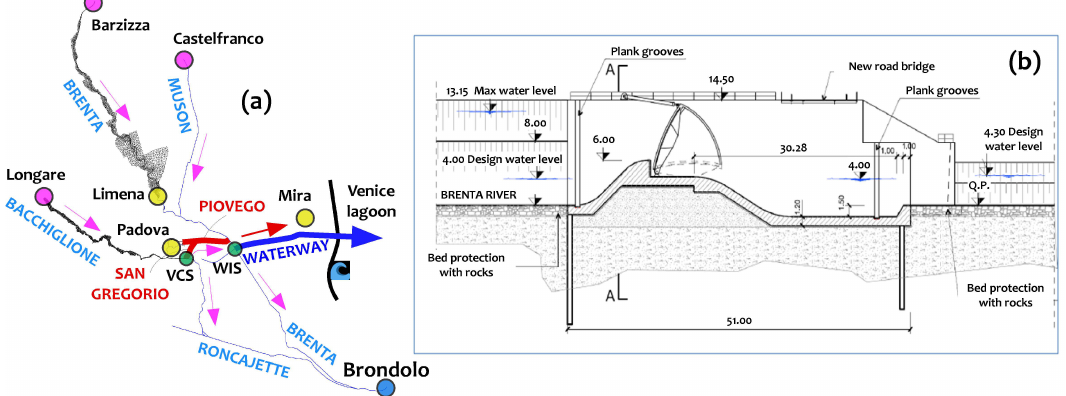
Figure 3. ( a ) Domain of the study and the computational mesh used to model flood propagation in the Brenta–Bacchiglione river network. Violet points denote the inflow boundary conditions; green points are the hydraulic facilities (the Voltabarozzo control structure, VCS, and the waterway intake structure, WIS); the blue point locates the mouth of the Brenta in the Adriatic Sea at Brondolo. ( b ) Details of the waterway intake structure